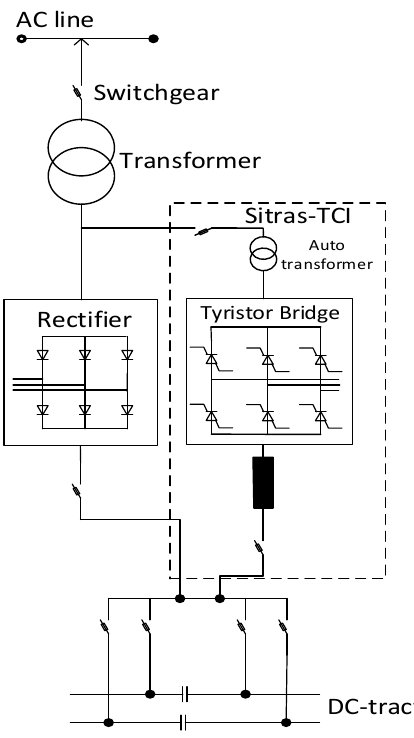
Figure 15. Siemens Sitras-TCI substation.